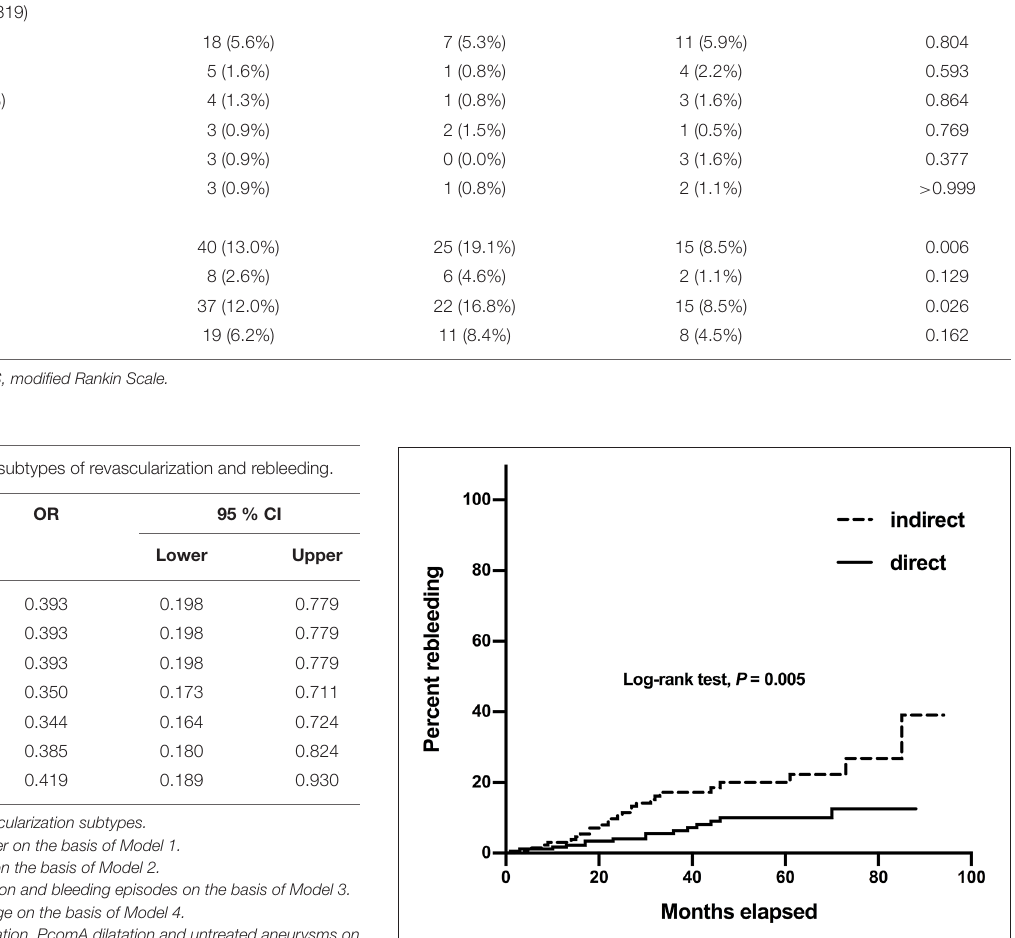
Total Indirect Direct ( n = 319/308) ( n = 133/131) ( n = 186/177)